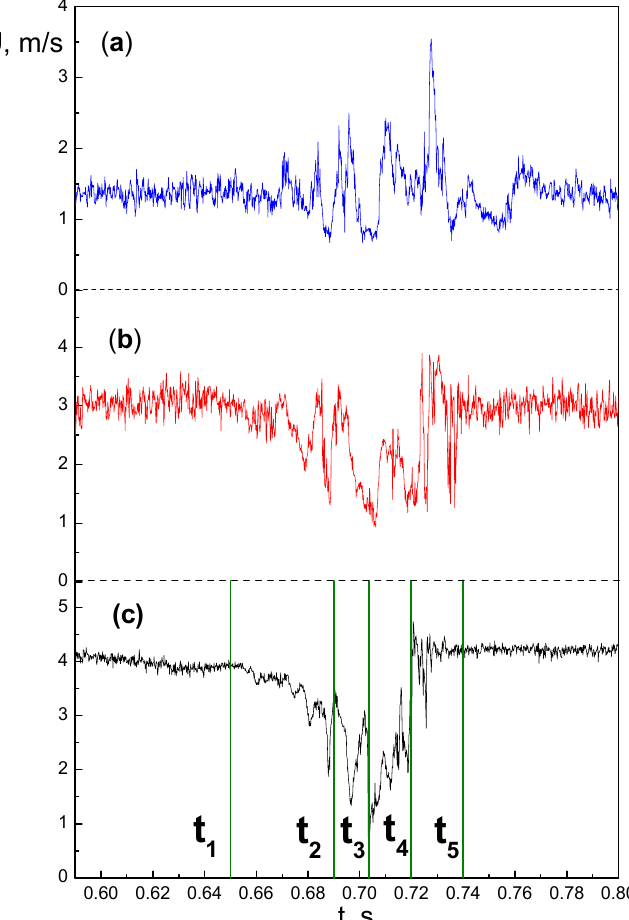
Figure 5. Time series of the single puff velocity in the mixing layer at distance r = 4 mm ( a ) and r = 3 mm ( b ) from the axis and on the axis ( r = 0) ( c ) in the cross-section x = 60 mm (CO 2 ), Re = 2400. t 1 = 0.65s; t 2 = 0.69 s; t 3 = 0.7 s; t 4 = 0.72 s; t 5 = 0.74